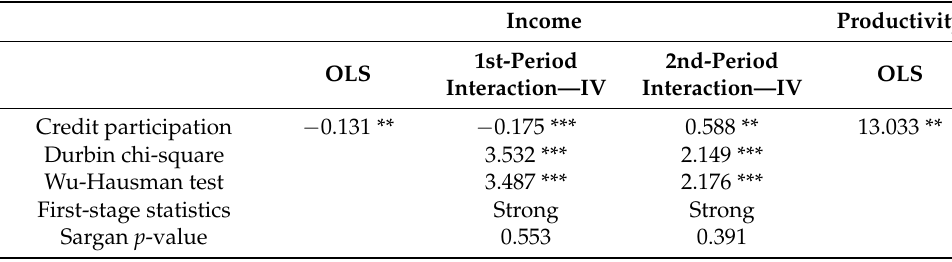
Table 6. Parameter estimates for farmers’ income and diagnostic